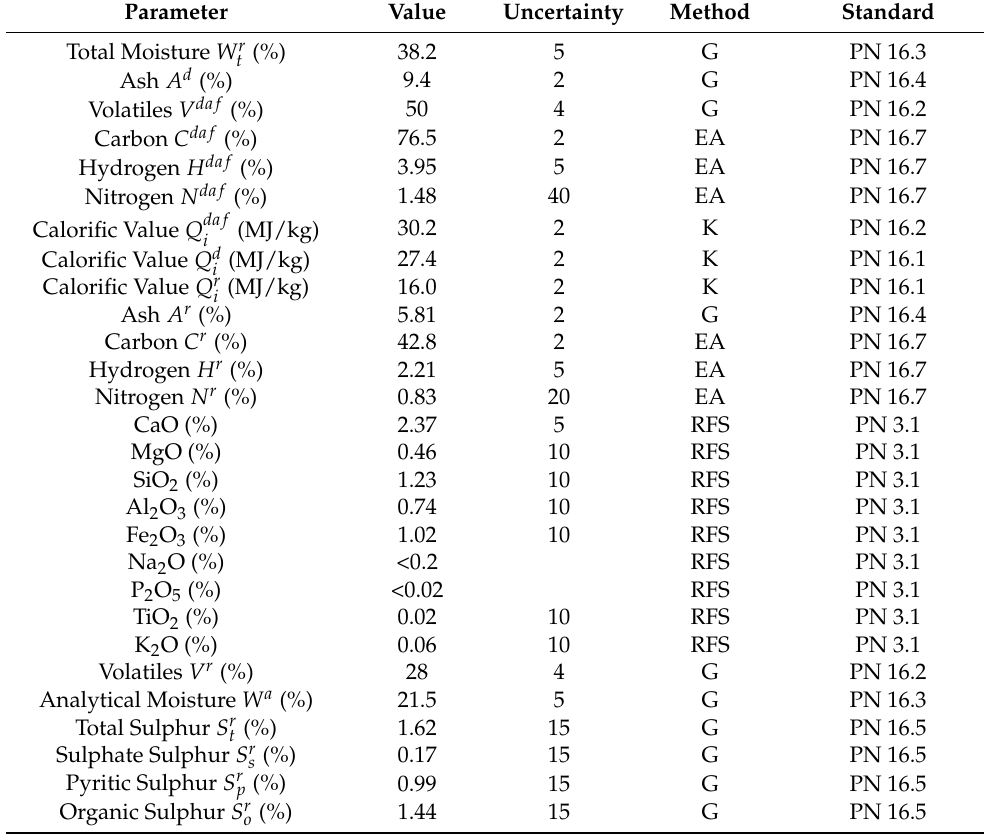
Table 1. The analysis of coal with the help of Slovak testing standards used by an accredited laboratory (Abbreviations: r—received, d—dry, daf—dry, ash-free, a—analytical, G—Gravimetry, EA—elementary analysis with heat conductive detector, K—Calorimetry, RFS—X-ray fluorescence spectrometry) (Source: own